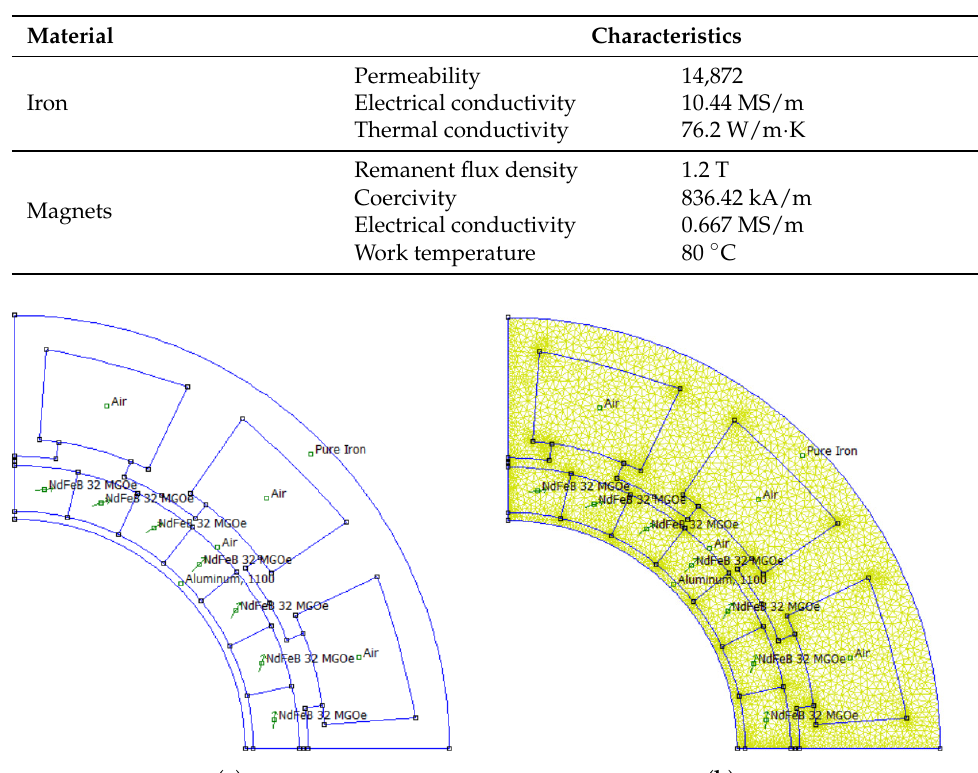
Figure 8. Structure with Halbach array magnet with progressive magnetization ( a ) and its 2D mesh ( b ).